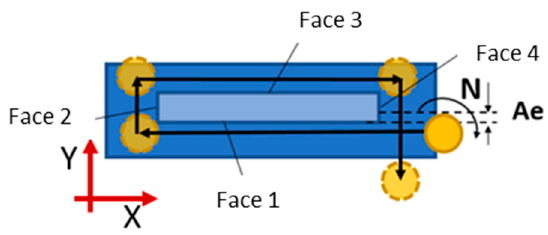
Figure 3. Tool path for the tangential milling.